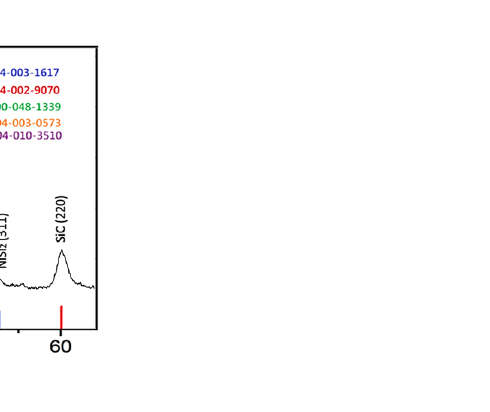
Figure 2. The XRD pattern of as-synthesized